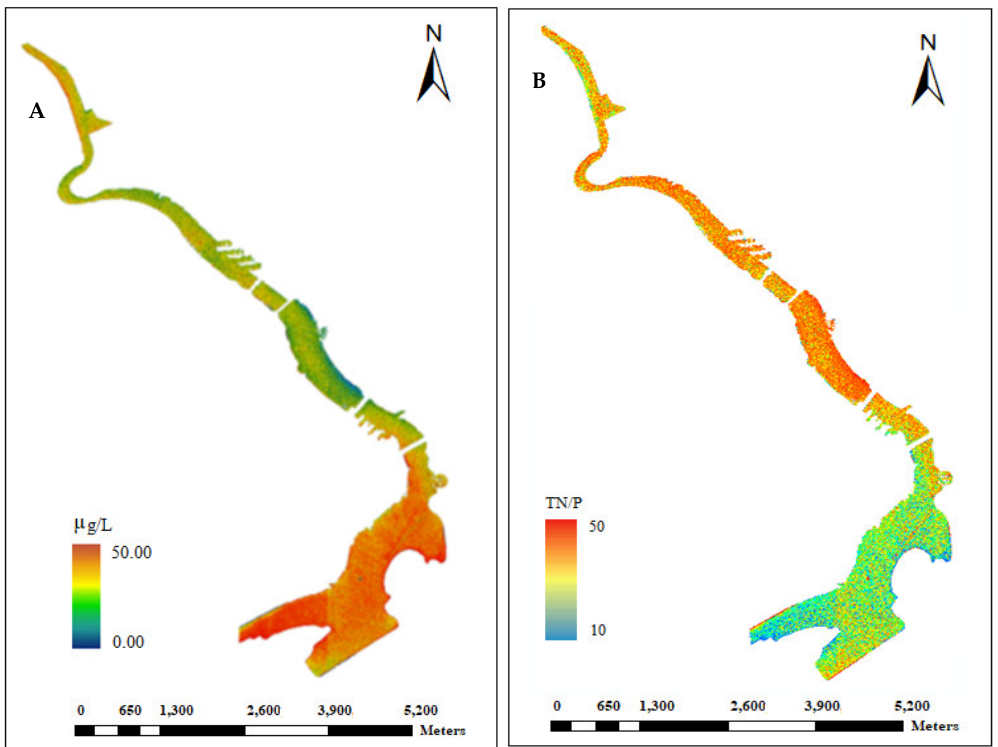
Figure 6. ( A ) Chlorophyll-a map extracted from WorldView-2 image of 24 July 2012, ( B ) TN/P (mass/mass) Ratio.